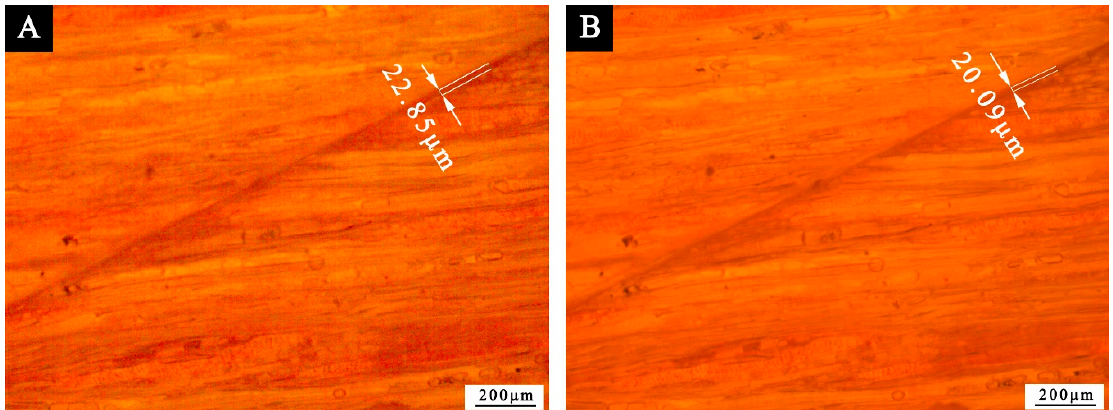
Figure 10. The OM diagram of paint coating without microcapsule: ( A ) 0 d, ( B ) 5 d.